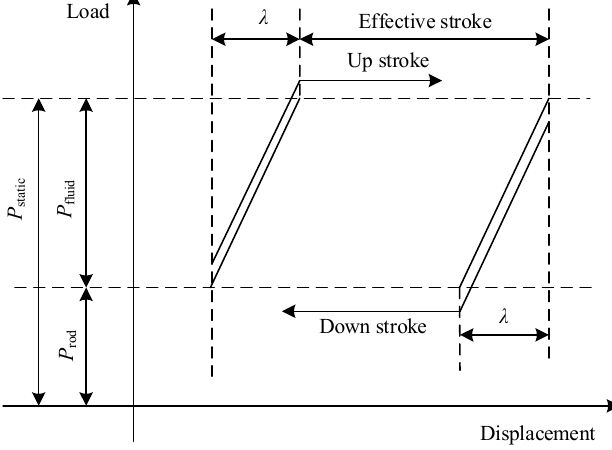
Figure 2. Theoretical indicator diagram under static load.